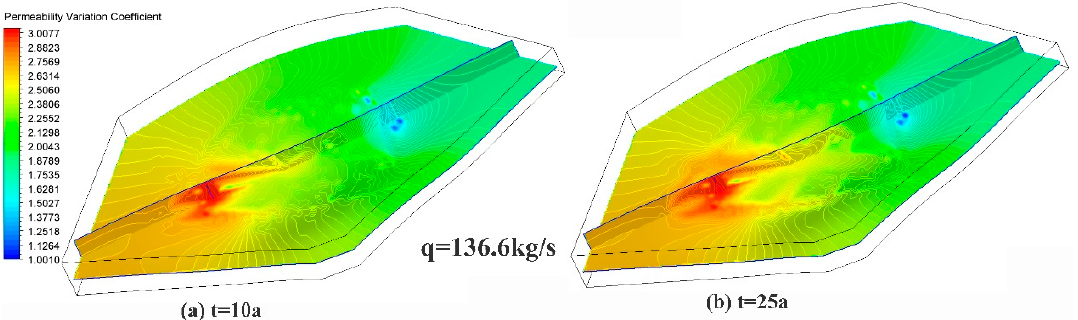
Figure 15. Contour of permeability variation coefficient ( k / k 0 ).